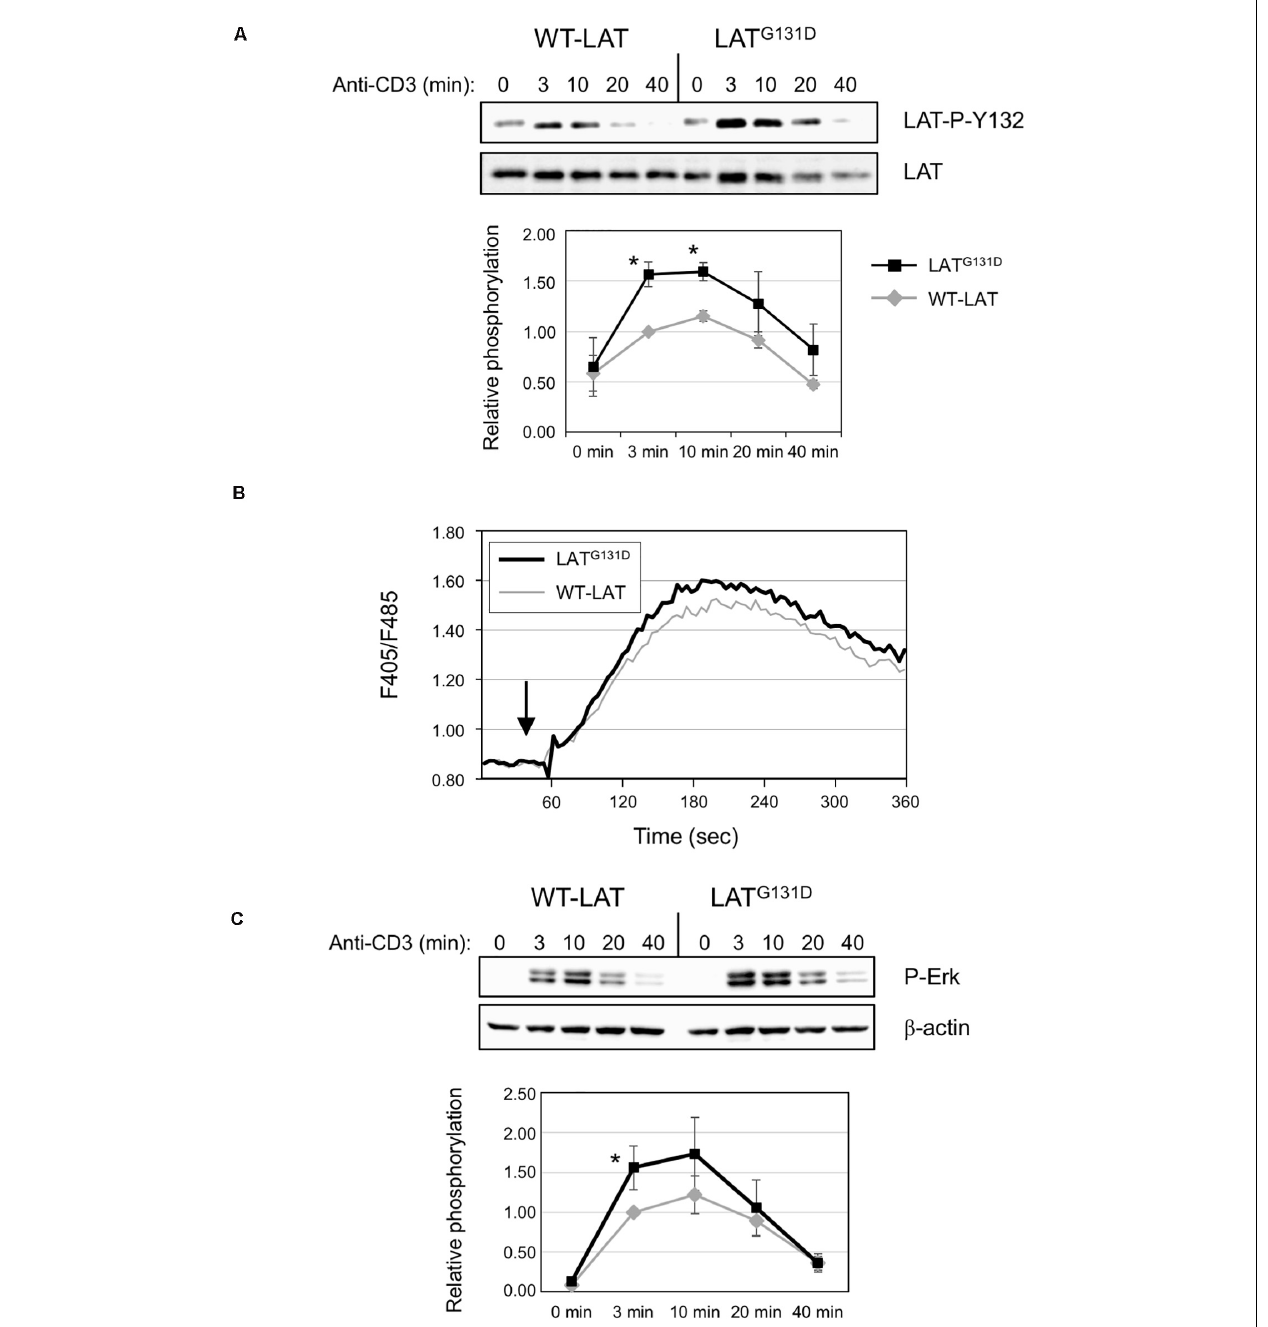
FIGURE 1 | Mutation of Gly 131 to Asp increases TCR-dependent intracellular signaling. (A) Immunoblots analyzing phosphorylation of LAT at tyrosine residue 132 in cells stimulated with soluble anti-CD3 were done with the phospho-specific antibody. Membranes were stripped and blotted with anti-LAT antibody (middle panel). The lower diagram represents the mean fold increase in phosphorylation in four independent experiments using J.CaM2 cells expressing WT-LAT (gray line) or the LAT G131D mutant (black line). Phosphorylation levels were normalized to total LAT expression. Bars represent the standard error. The asterisk represents statistical significance. (B) J.CaM2 cells expressing WT-LAT or the LAT G131D mutant were loaded with Indo-1AM and stimulated with OKT3 mAb (1 µ g/ml) at the indicated time (black arrow). The intracellular Ca 2 + concentration was determined at 37 ◦ C through the change in Indo-1AM fluorescence. The graphic represents the average of five experiments. (C) Whole-cell lysates were probed by Western blotting for the activation of Erk by using a mAb recognizing doubly phosphorylated on specific threonine and tyrosine residues on Erk (upper panel). Stripped membranes were blotted with anti- β -actin mAb to show equal protein expression (middle panel). Lower diagram represents the mean fold increase in Erk phosphorylation in four independent experiments using J.CaM2 cells expressing WT-LAT (gray line) or the LAT G131D mutant (black line). Phosphorylation levels were normalized to β -actin expression. Bars represent the standard error. Asterisk represents statistical